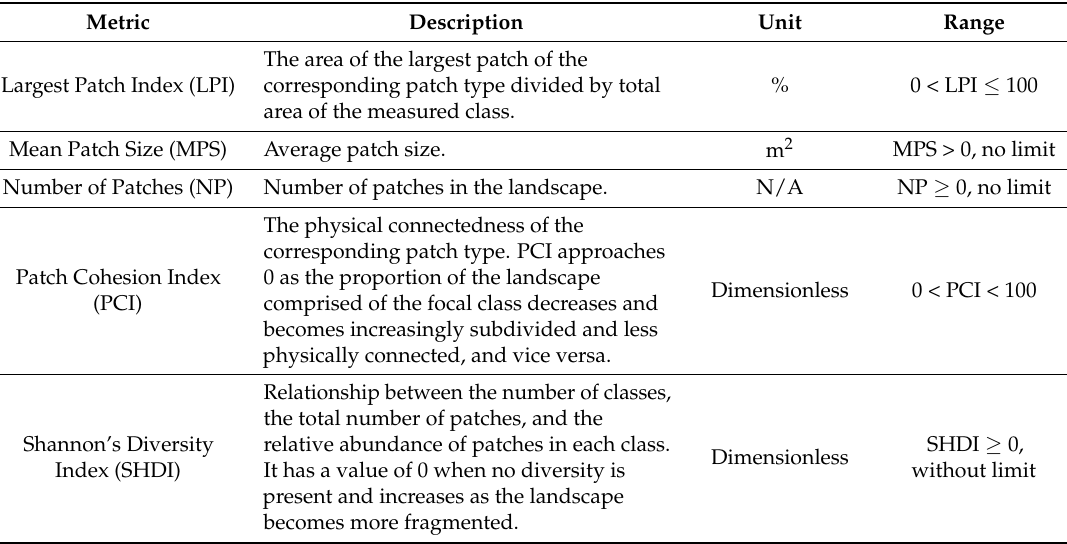
Table 5. Description of spatial metrics.